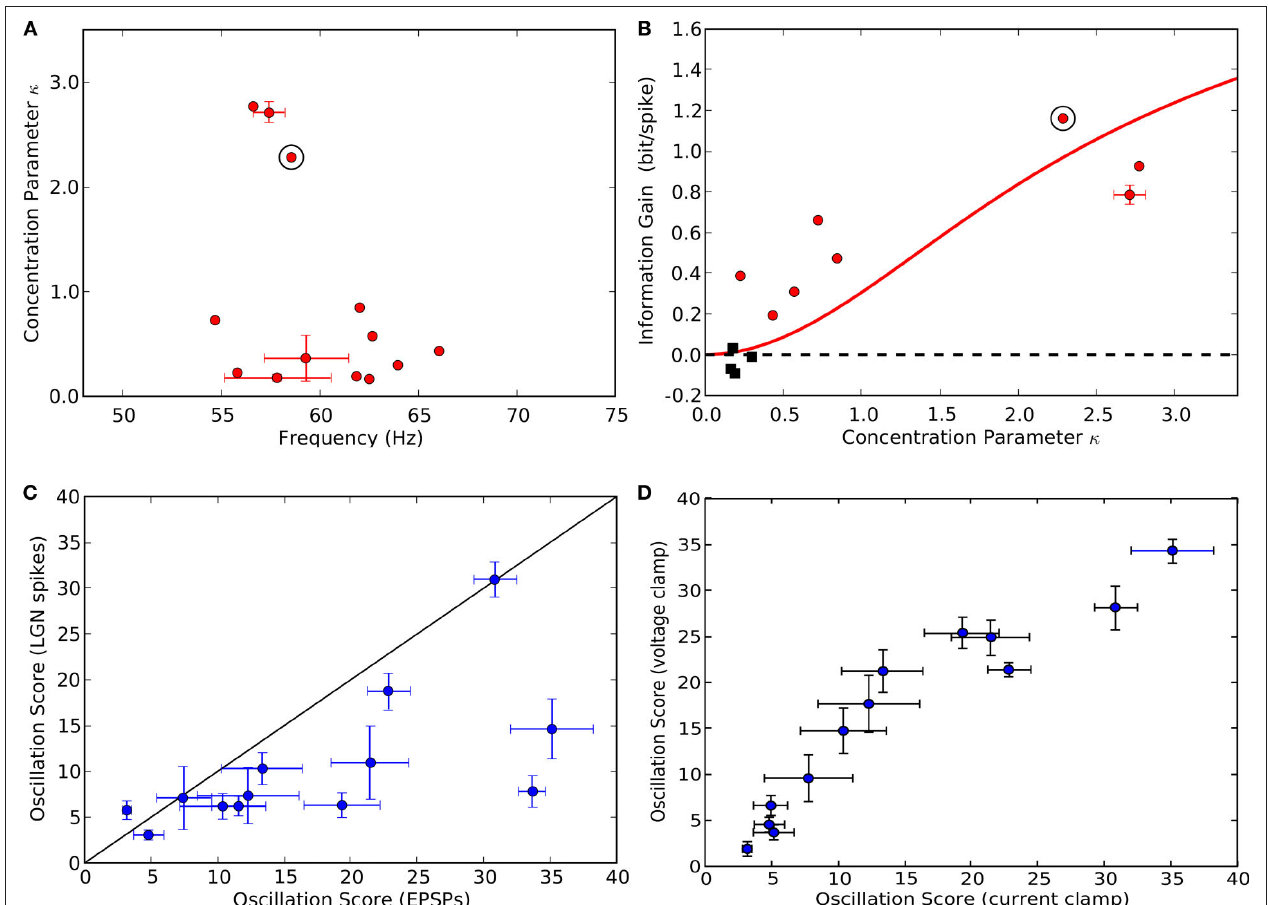
FIGURE 9 | Population results for phase locking, information gain and oscillation score. (A) Phase locking of thalamic spikes for all (13/20) cells that had oscillating EPSP trains (see Table 1 ). Error bars indicate standard deviation for cases in which multiple movies were presented; circled point indicates the cell analyzed in Figures 2, 3, 7 and 8 . (B) Gain in information rate after de-jittering plotted against concentration parameter κ ; conventions as in (A) . For 8 of 20 cells (red points), the